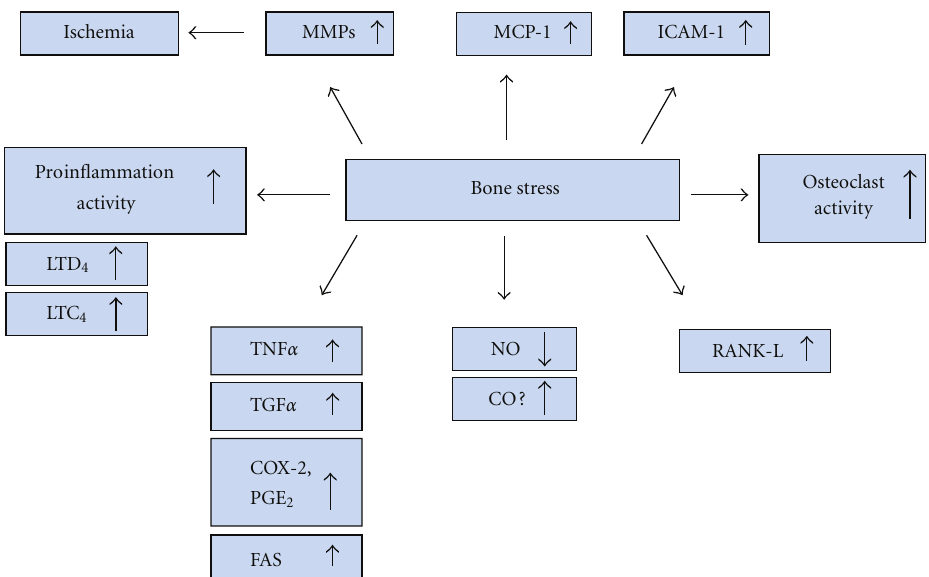
Figure 1: Diagram representing the adverse e ff ects of stress on bone, leading to the releases of inflammatory